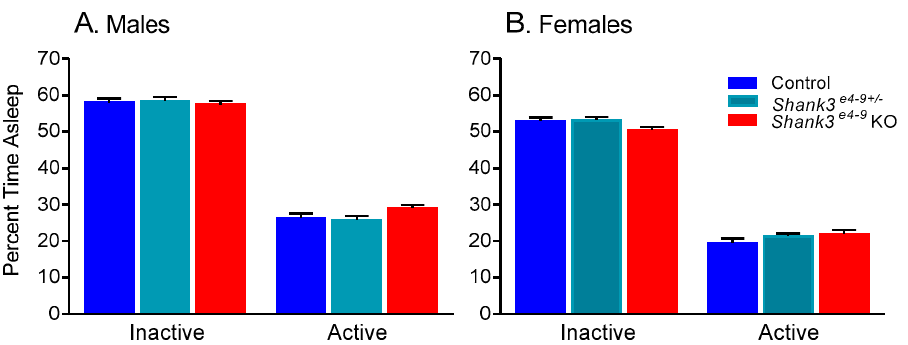
Figure 3. Sleep duration in Shank3 e4-9 KO, Shank3 e4-9+/ − , and control male ( A ) and female ( B ) mice. We found a statistically significant genotype x phase ( p = 0.002) interaction (Table 1). Post-hoc tests showed that KO mice tended to sleep more in that active phase compared to control mice ( p = 0.059). We also found statistically significant main effects of phase and sex (Table 1). Mice slept less in the active phase than in the inactive phase ( p < 0.001). Female mice slept less than male mice ( p < 0.001). Bars represent means ± SEM for 20 control male, 31 Shank3 e4-9+/ − male, 22 KO male, 23 control female, 25 Shank3 e4-9+/ − female, and 22 KO female mice.